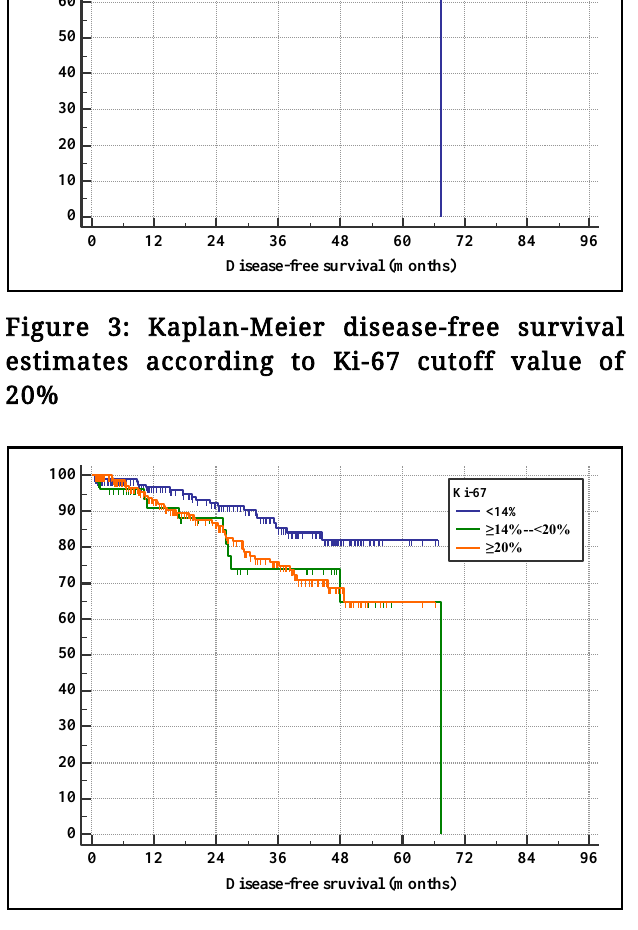
Figure 4: Kaplan-Meier disease-free survival estimates according to Ki-67 stratified into 3